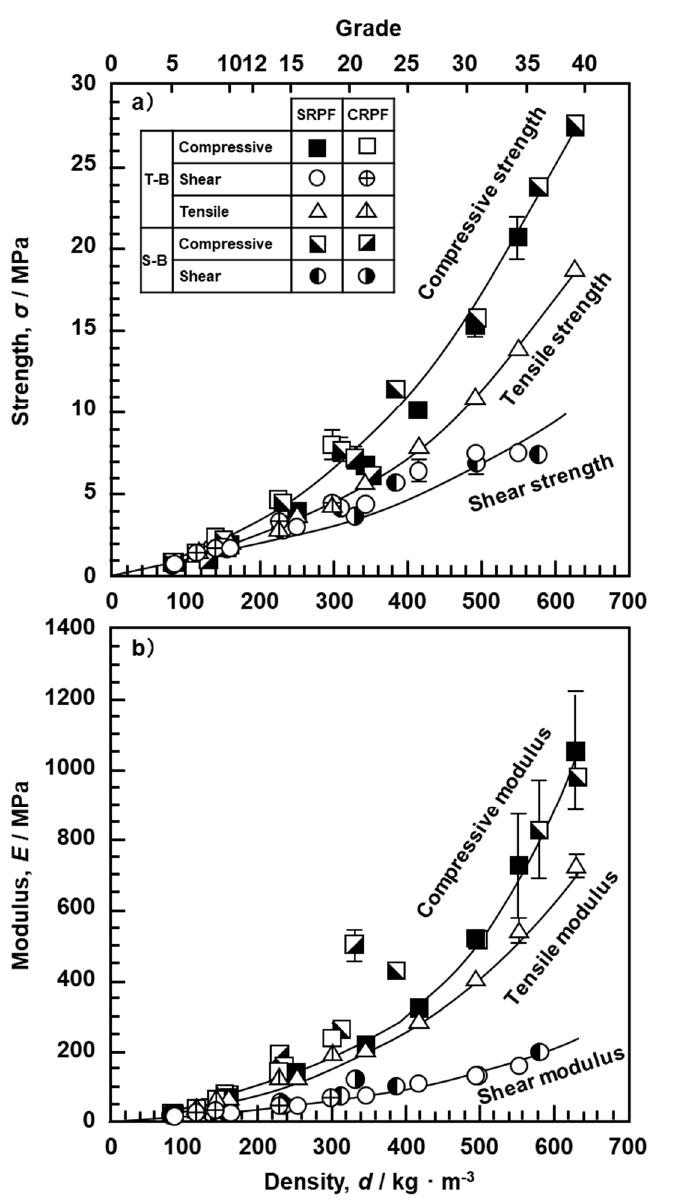
Figure 8. Effect of density on strength and modulus obtained by compressive, shear, and tensile tests with T- and S-bones. ( a ) Strength and ( b ) Modulus.